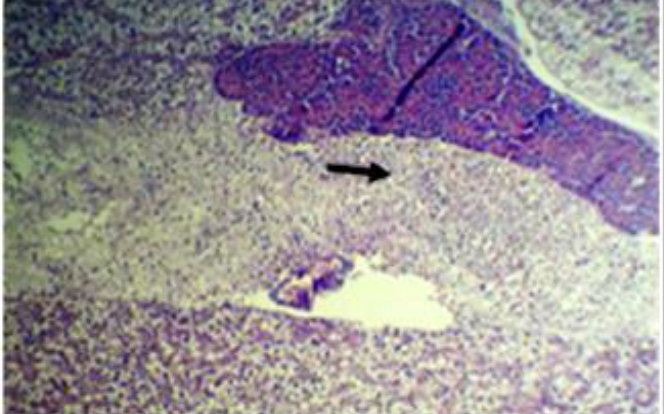
Figure 7. Histopathological section of gills shows congestion of central venous sinus vessels ( ) with interstitial edema and inflammatory cells infiltration